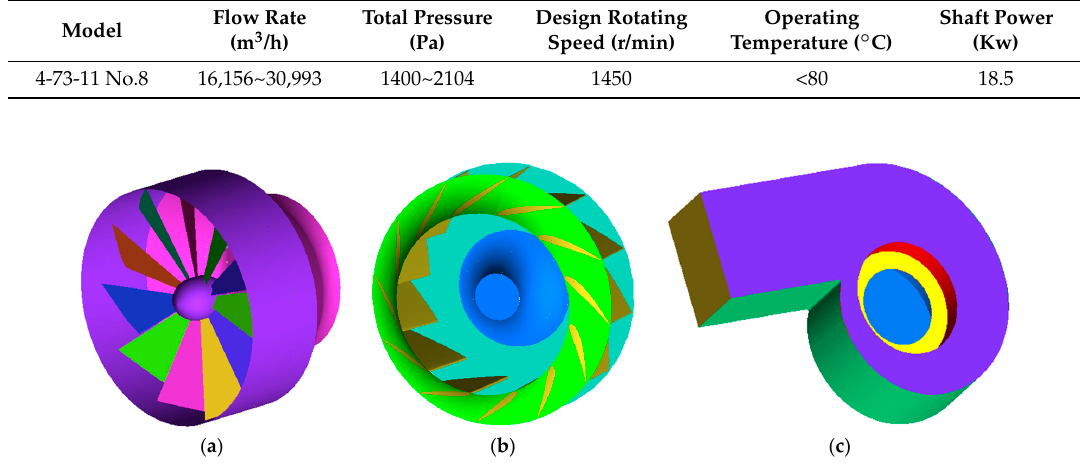
Figure 2. Computation model of CF: ( a ) leading-blade (LB); ( b ) impeller; and ( c ) volute.